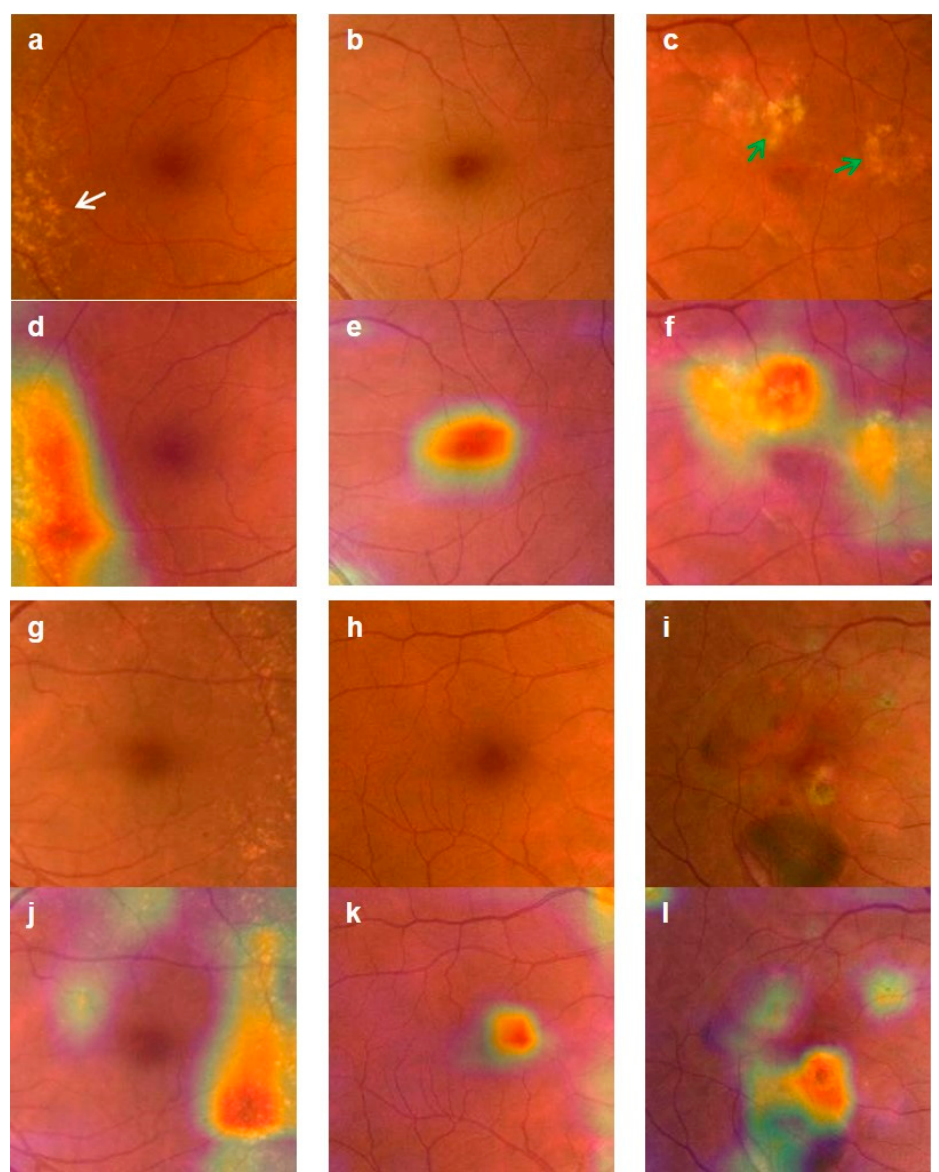
Figure 5. Examples of class activation map (CAM) visualization. CAM visualization of normal, dry age-related macular degeneration (dAMD), and neovascular age-related macular degeneration (nAMD) retinas. CAM extracts the feature map of the last convolution layer (Conv5_3) and shows a heatmap within the image describing the calculated weight of the feature map. ( a ) dAMD fundus images show drusen (arrow), and ( d ) heatmap images show drusen identified by the artificial intelligence (AI) tool; ( b ) Normal fundus images have no drusen, and ( e ) heatmap images of normal controls show that the AI tool identified the contour of fovea according to the absence of drusen; ( c ) nAMD fundus images show bleeding and degenerated areas (green arrows), and ( f ) heatmap images show identified drusen and other features of degeneration and bleeding; ( g – i ) Representative images of dAMD, a normal control, and nAMD, respectively; ( l ) Heatmap images of nAMD show that the AI tool identified pathological changes in the macula, such as elevation of the center; ( j ) There was no heatmap at the center of dAMD; however, the AI tool detected drusen instead; ( k ) Heatmap image showing AI identification of the center of the macula in a control, with no degenerated area.